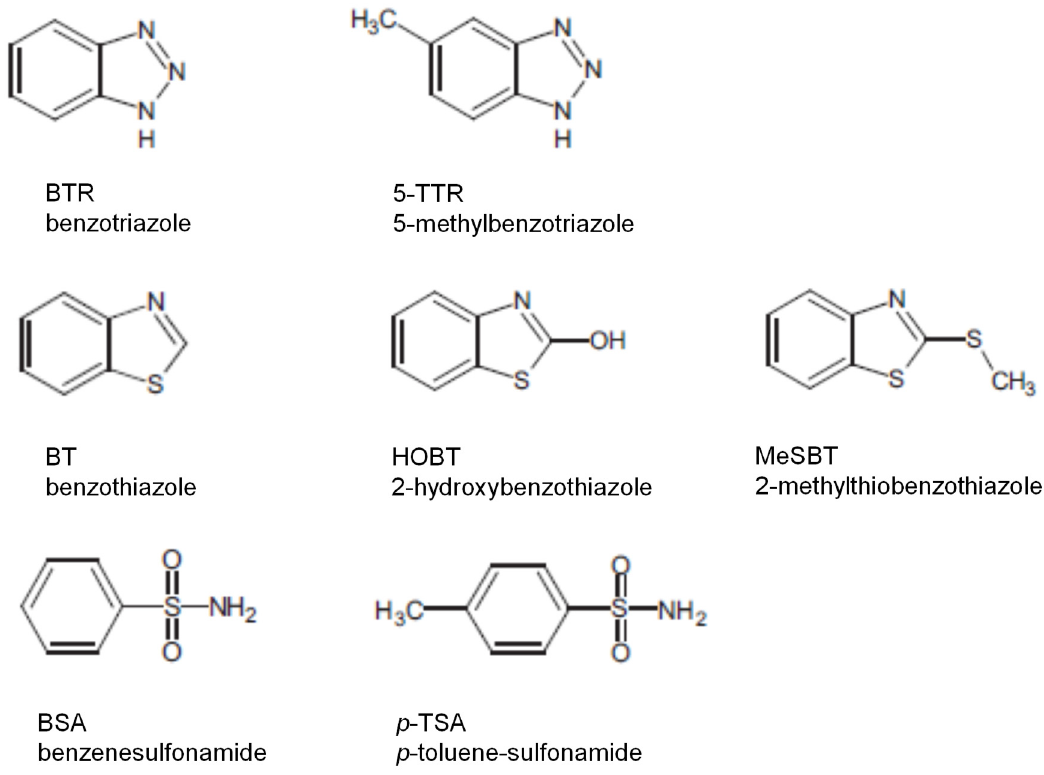
Figure 1. Chemical structures of the tested benzo-fused nitrogen heterocyclic compounds.